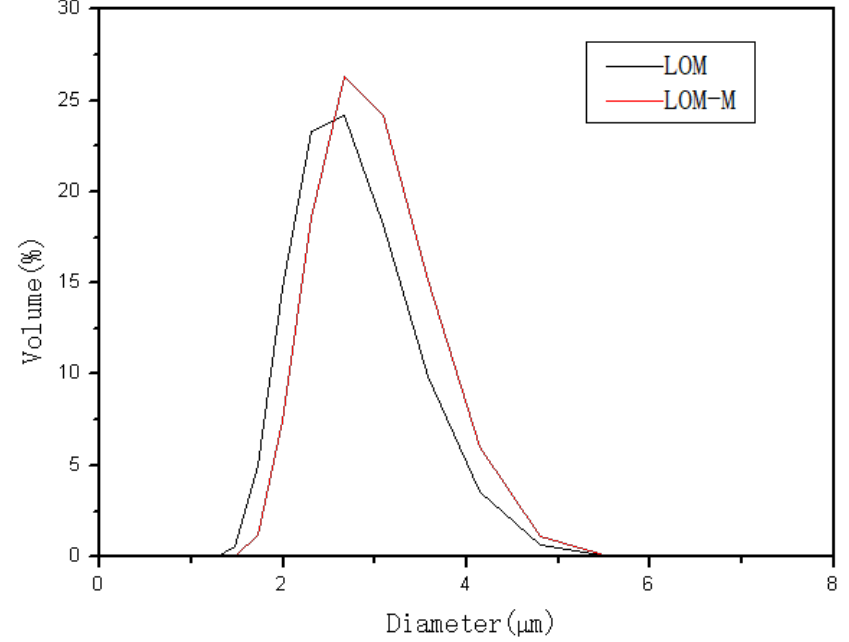
Figure 2. Particle size distribution of single-layered microcapsules (lavender essential oil (LOM) and double-layered microcapsules (LOM-M).